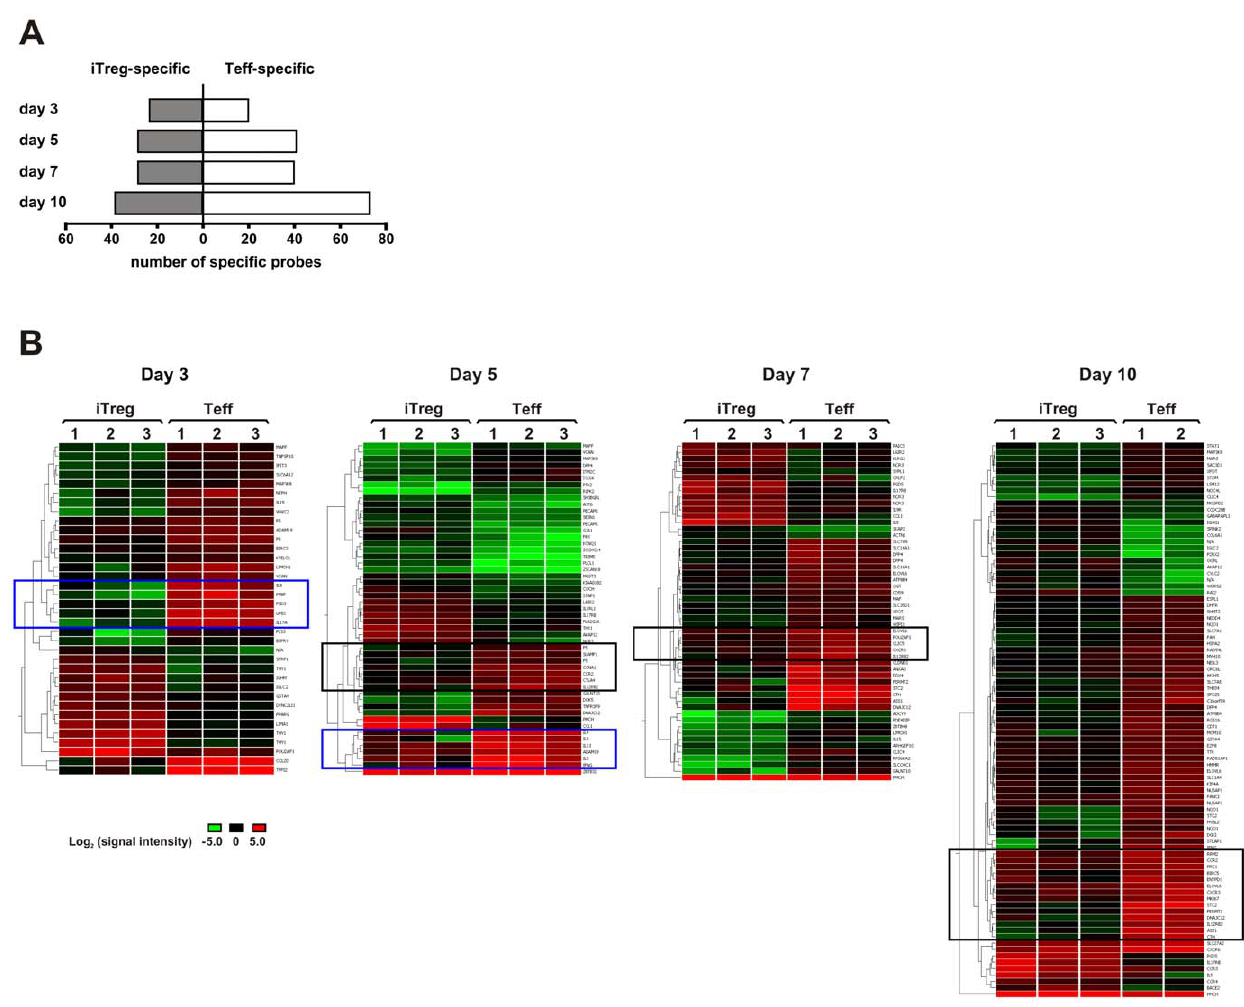
Figure 3. iTreg and Teff specific transcripts during development. (A) Number of probes specifically expressed in iTregs and Teffs at different times during differentiation. (B) Hierarchical clustering was performed on 93 iTreg-specific and 142 Teff-specific probes. Red and green colors indicate high and low levels of expression, respectively. Rows correspond to individual transcripts. Columns reflect results from three individual donors denoted as 1 to 3. Cytokine clusters are highlighted by blue boxes (IL8 and IL17A at day 3; and IL3, IL4, IL9, IFNG and IL13 at day 5). Black boxes denote a cluster of inflammation-related surface proteins.